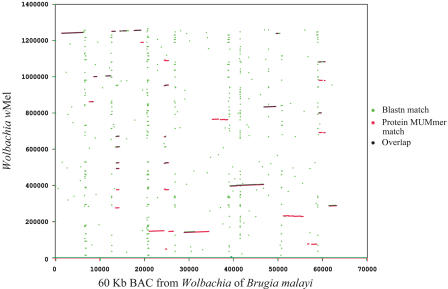
Alignment of wMel with a 60 kbp Region of the Wolbachia from B. malayi
The figure shows BLASTN matches (green) and whole-proteome alignments (red) that were generated using the “promer” option of the MUMmer software (Delcher et al. 1999). The B. malayi region is from a BAC clone (Ware et al. 2002). Note the regions of alignment broken up by many rearrangements and the presence of repetitive sequences at the regions of the breaks.